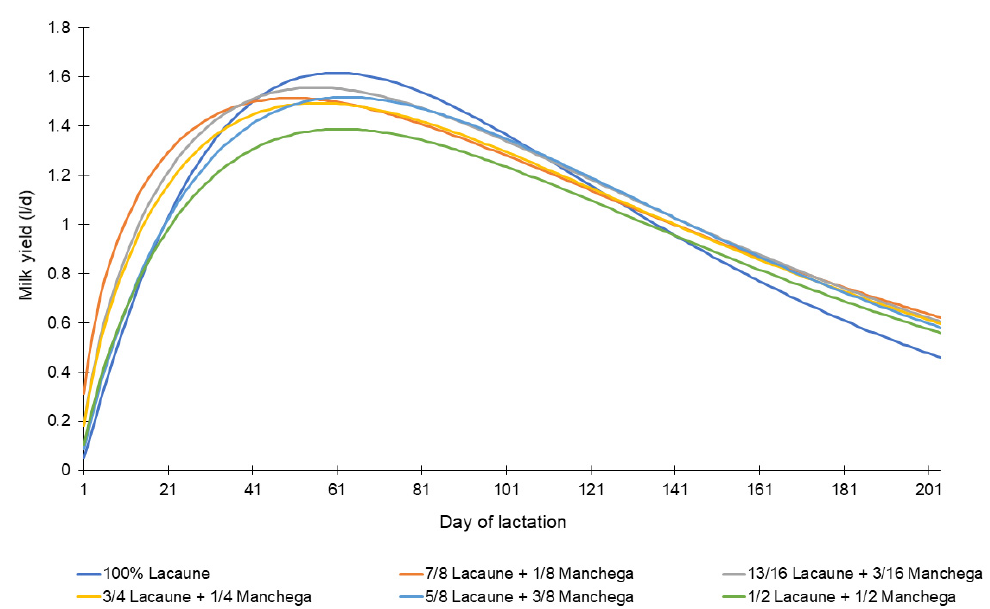
Figure 2. Lactation curves (fitted with the Wood gamma model) of Lacaune and their crosses at different degrees with Manchega dairy sheep from a commercial flock in Spain.